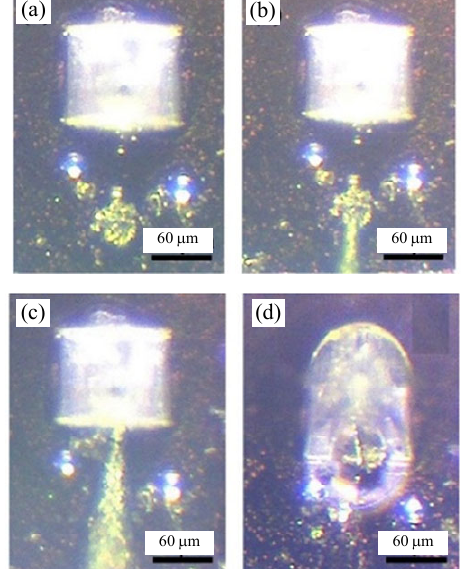
Fig. 7 Flow chart of graphene powder and “arch bridge” microstructure micro-assembly: (a) placing the graphene powder in front of the “arch bridge” shaped microstructure with an unheated probe tip, (b) heating the probe to 400 and ℃ moving the graphene powder, (c) using the heated probe to assemble the graphene powder into the microstructure on a 2D plane, and (d) observing the assembled microstructure at an inclined angle of 30°, the graphene powder was placed inside the